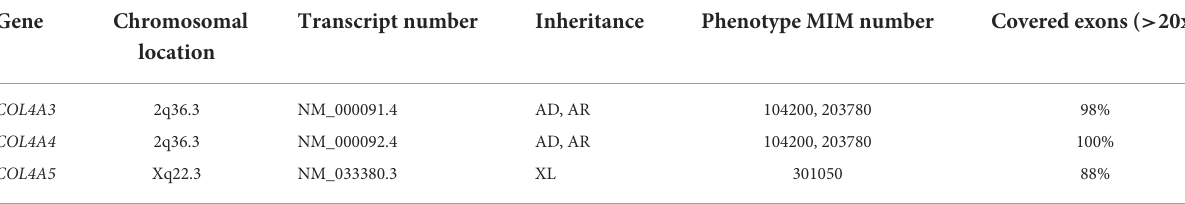
TABLE 1 Exon coverage of genes COL4A3-5 in exome sequencing.